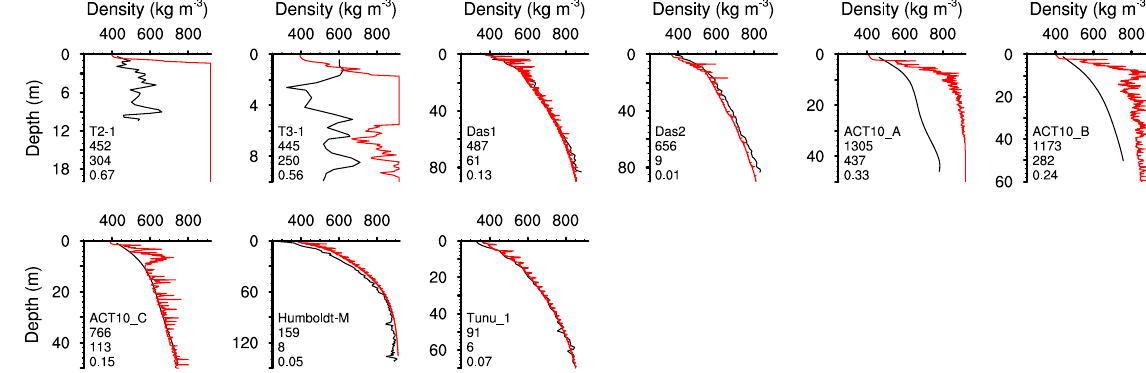
Figure A2. Observed (black) and modelled (red) firn density profiles for 9 of the 62 firn cores on the Greenland Ice Sheet. The four lines of text in each panel shows (1) the core name, (2) mean annual accumulation and (3) melt (in mmw.e.yr − 1 ) from RACMO2.3, and (4) the ratio of these fluxes ( R ma , dimensionless). The other vertical profiles are shown in Figs. 3 and